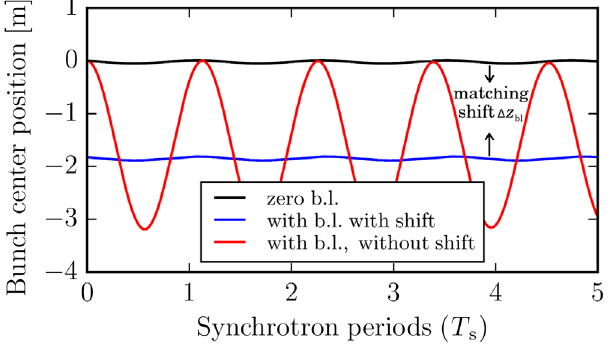
merging.FIG. 7. Evolution of bunch center position mismatched (in red) and matched (in blue) to beam loading: The red curve indicates the mismatched dipole oscillation because of beam loading, while the blue curve represents the matched case with a shift Δ z on bunch center. For comparison, the ideal case in the absence of beam loading is also shown (in